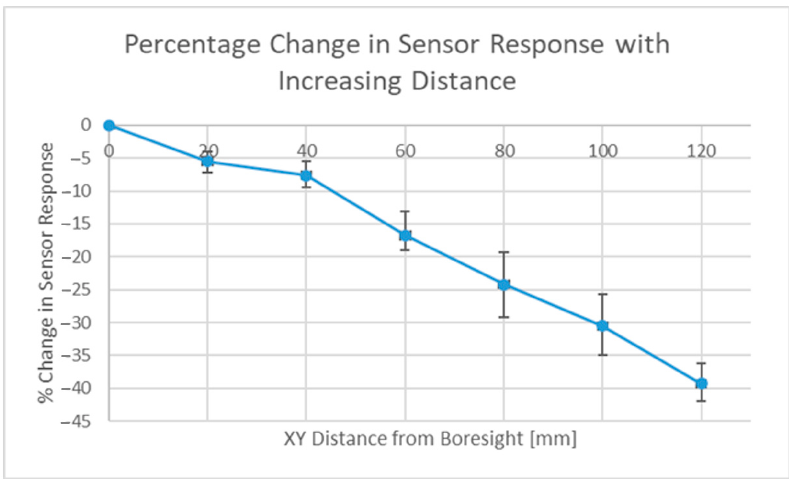
Figure 17. Standard (fully overlapped) distribution response magnitude results.